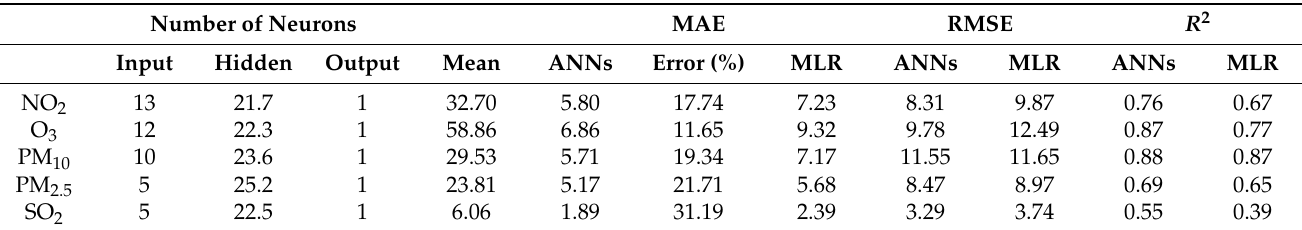
Table 4. Number of input, hidden (average) and output neurons as well as the average Mean Absolute Error (MAE), Root Mean Squared Error (RMSE) and coefficient of determination ( R 2 ) values and mean concentrations for the best performing models and the 2016/2017 time period. The MAE, RMSE and R 2 metrics include the results for the Multiple Linear Regression (MLR) scheme. For the MAE metric, the percentage of error (MAE to mean concentrations) was additionally